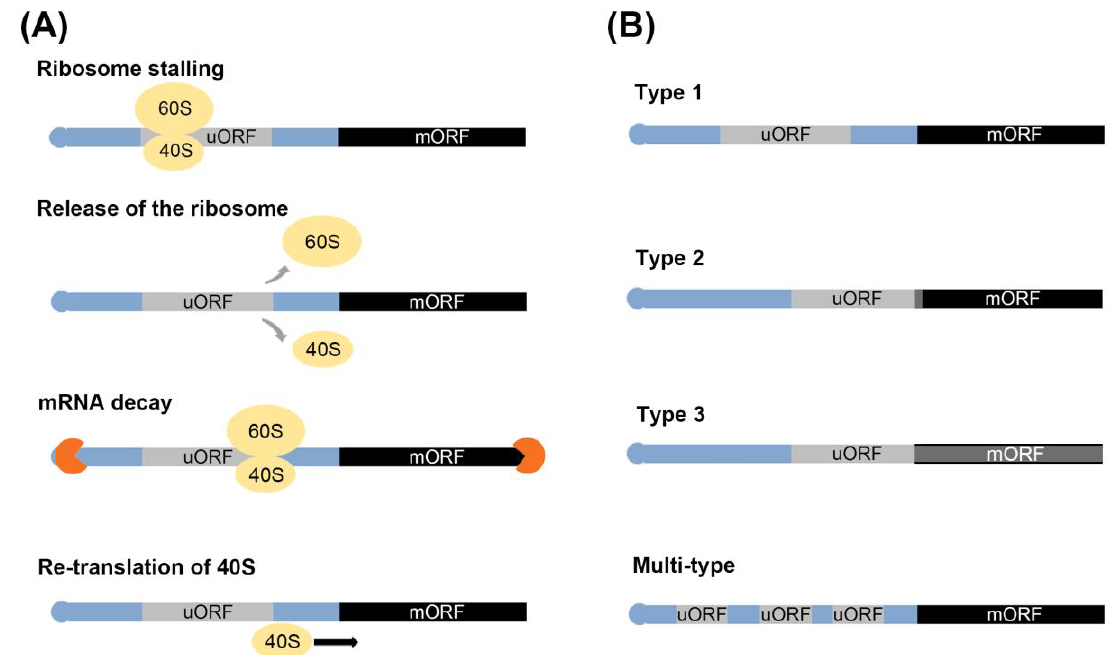
Figure 2. Regulation of uORF-mediated translation and types of uORF. ( A ) The various mechanism of translational repression. ( B ) Types of uORFs. uORFs are classified multiple type and type 1–3. Blue, gray and black rectangles indicate regions of the mRNA, yellow ovals indicate the ribosome complex, and orange circles indicate the exosome.